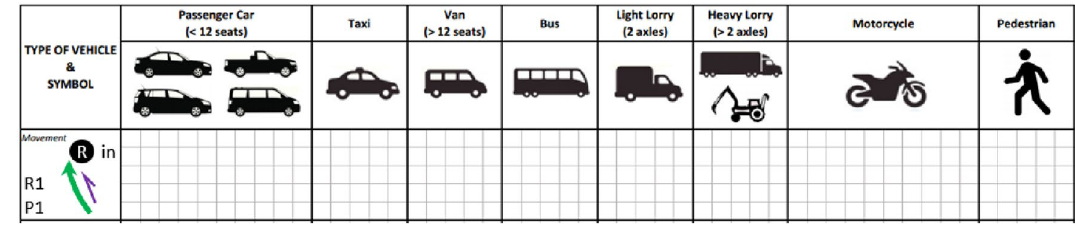
Figure 1. Traffic survey form.